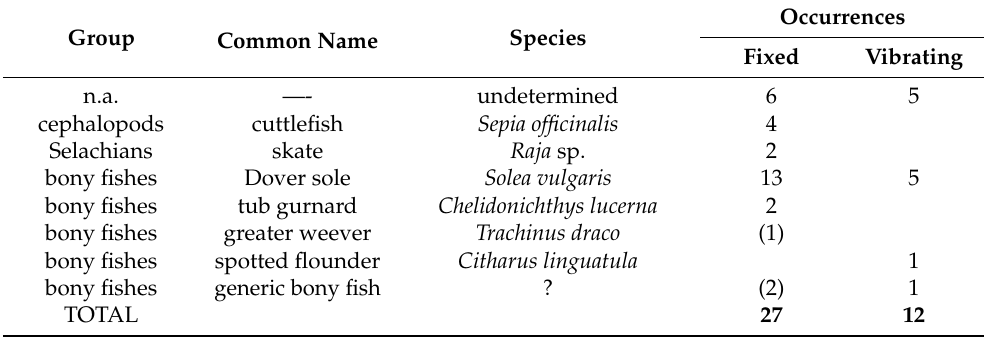
Occurrences Fixed Vibrating